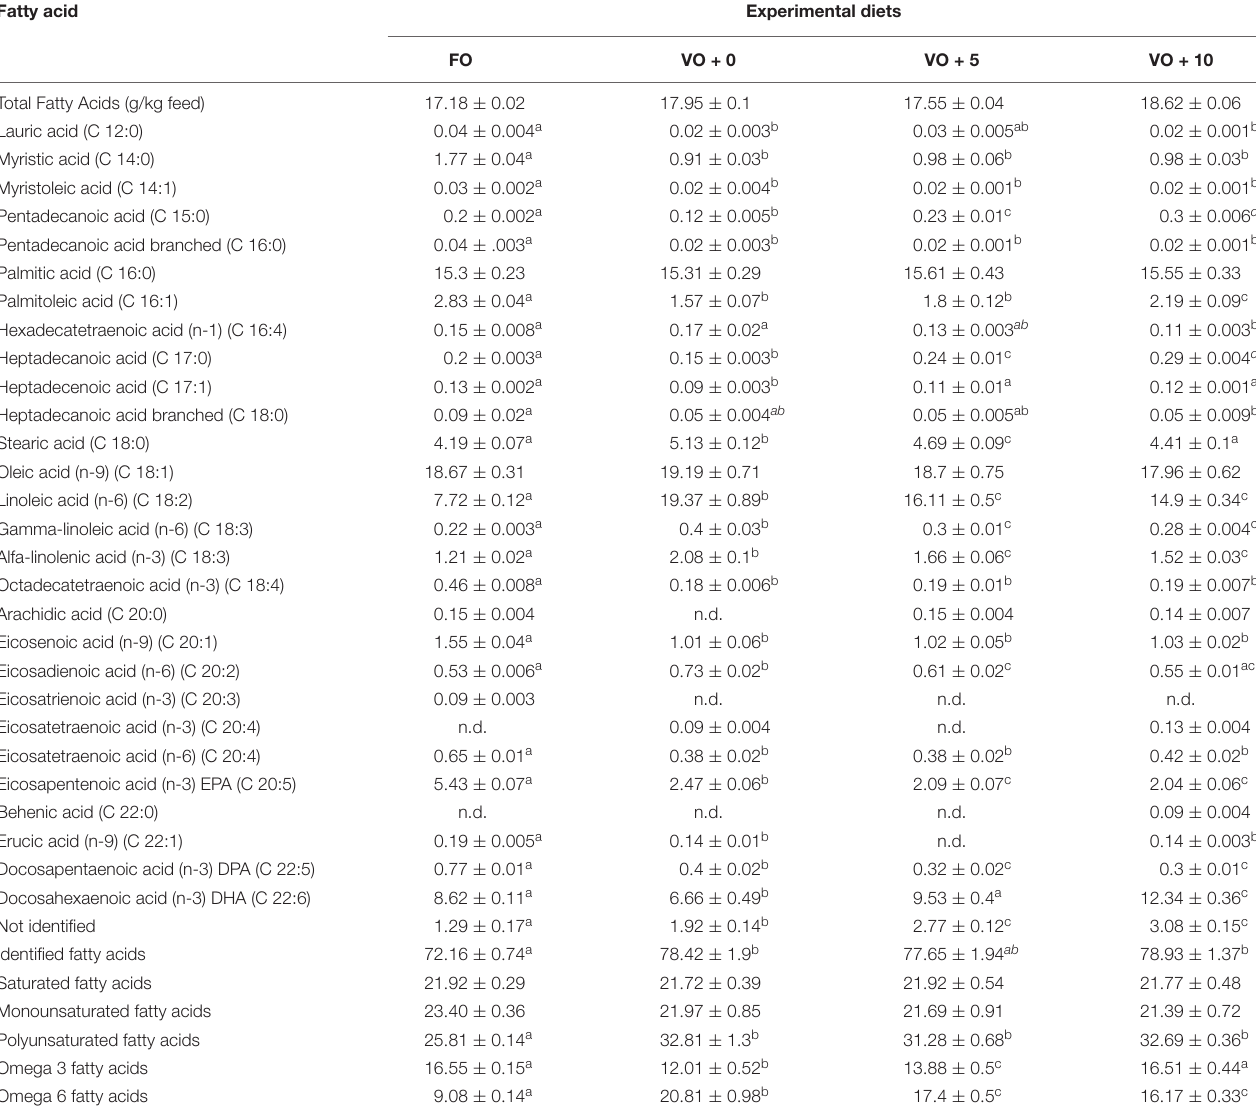
TABLE 7 | Fatty acids profile of filets in fish fed the four experimental